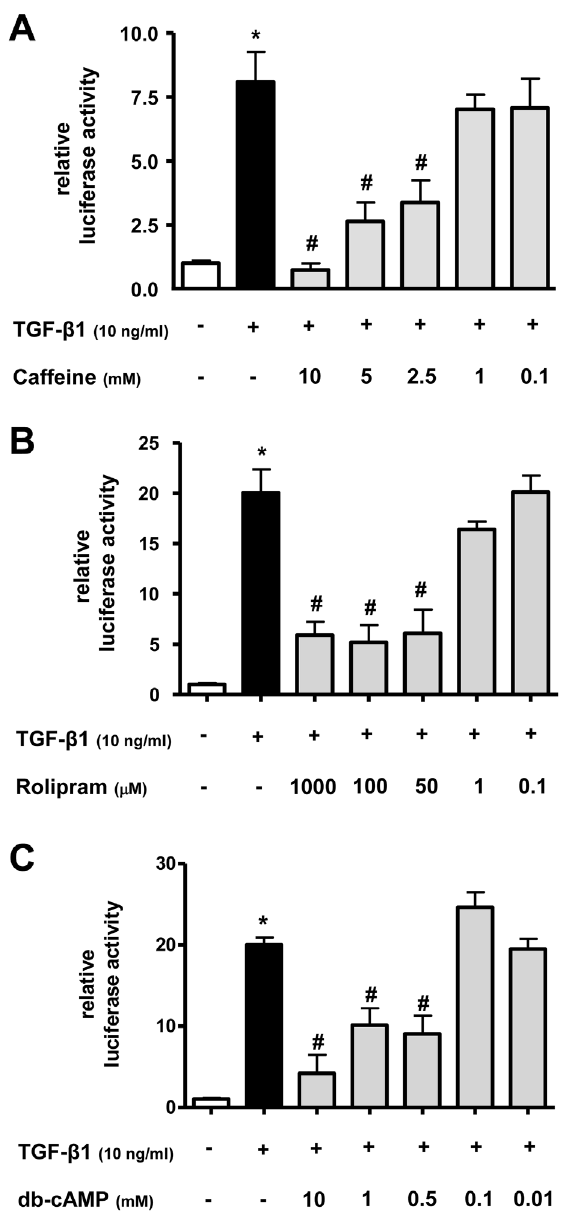
Figure 1. Caffeine, rolipram, and db-cAMP inhibit TGF- b 1 induced Smad-signalling in lung epithelial cells. The TGF- b 1– sensitive (CAGA) 12 -luciferase reporter construct was transiently trans- fected into A549 cells. Cells were then treated with TGF- b 1 (10 ng/ml) and/or different concentrations of caffeine (A), rolipram (B), or db-cAMP (C). Firefly luciferase activity was normalized to the activity of Renilla luciferase under control of the thymidine kinase promoter. Relative luciferase activity compared to controls is shown. * p , 0.05 compared to control cells, # p , 0.05 compared to TGF- b 1 treated cells.